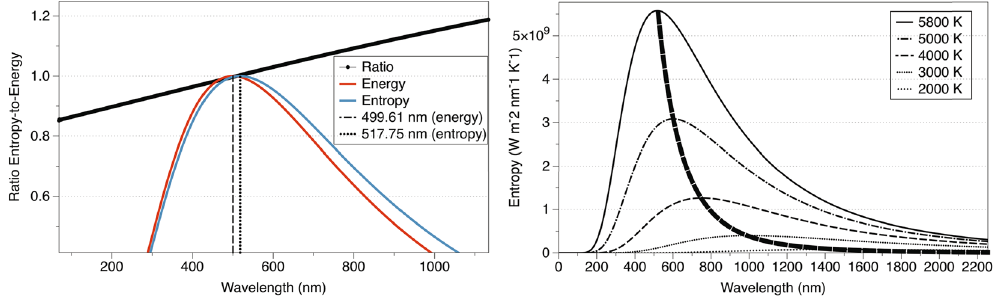
Figure 1. ( a ) (left): Normalized entropy (blue line) and energy (red line) of blackbody radiation at 5800 K. The ratio entropy-to-energy is determined by the black line. ( b ) (right): Entropy of blackbody radiation at different temperatures. The behaviour resembles the energy